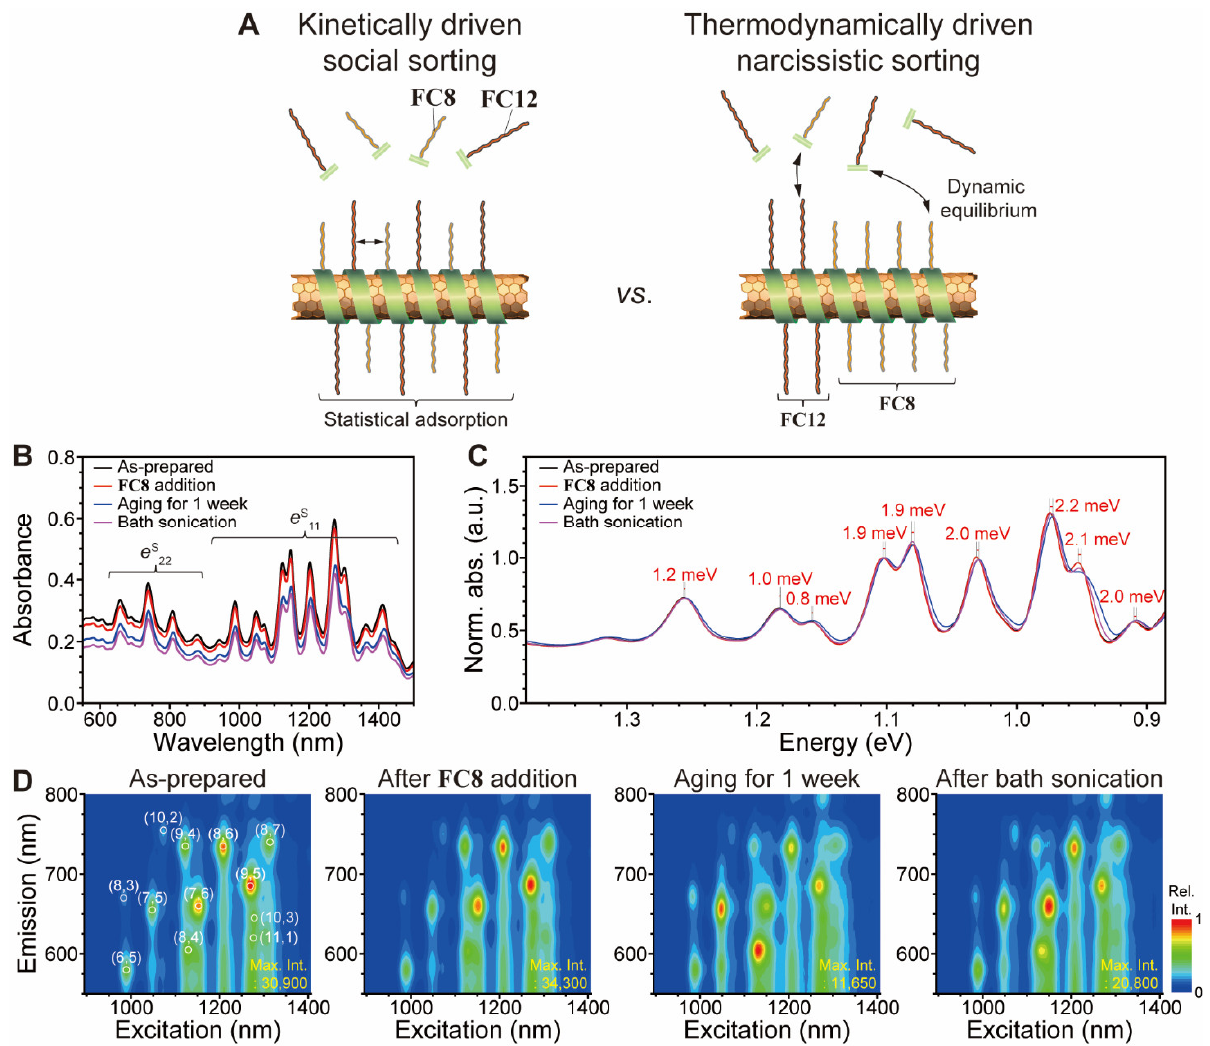
Figure 12. Social or narcissistic sortings of tandem FC8 / FC12 on SWNT affecting d t enrichment of SWNT dispersions. ( A ) Schematic of social sorting (left) and narcissistic sorting (right) modes of flavin derivatives on SWNT surface. ( B ) Comparison of absorption spectra from the as-prepared FC12 -PSWNT dispersion (black), and after the addition of isomolar FC8 (red), after the one-week aged (blue) and after the bath-sonicated sample (magenta). All absorption measurements were acquired by using a cuvette of beam path 10 mm. ( C ) The corresponding normalized e S 11 absorption spectra with d t -dependent redshift degree of the aged sample against 1.1 eV band. ( D ) PLE maps of FC12 -PSWNT and FC8 / FC12 -PSWNT dispersions with addition, aging, and bath sonication treatments. It is noteworthy that enriched chiralities of SWNT are different.